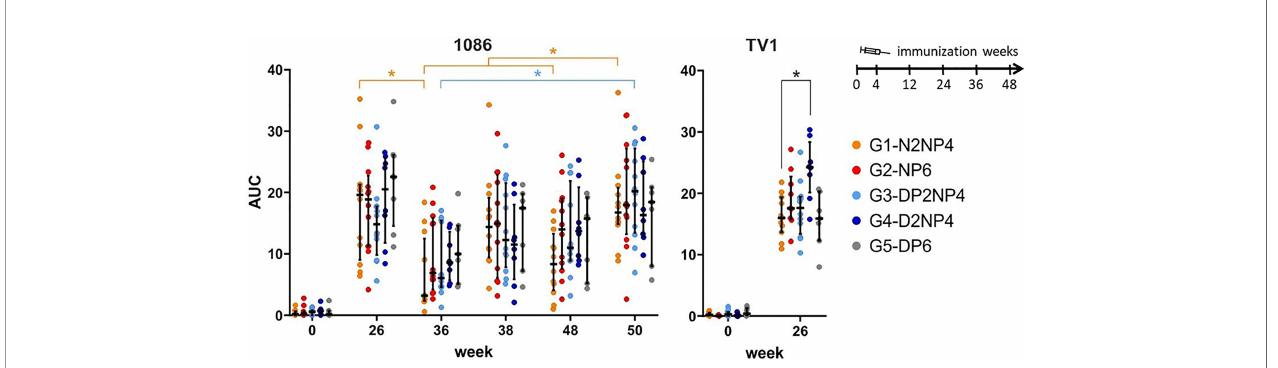
FIGURE 11 | Capacity of plasma samples to mediate ADCC. AUC values of the percent granzyme-B-positive target cells plotted against plasma dilution in the ADCC GranToxiLux assay, using gp120 of 1086 (left) and TV1 (right) as readout antigens coated onto target cells. Responses of individual monkeys are shown as colored dots and median and interquartile ranges are represented as black lines. The within-group comparisons (left panel) were made using the Wilcoxon signed- rank test and the between-group comparison (right panel) was performed using the Wilcoxon rank sum test (Bonferroni-corrected). *